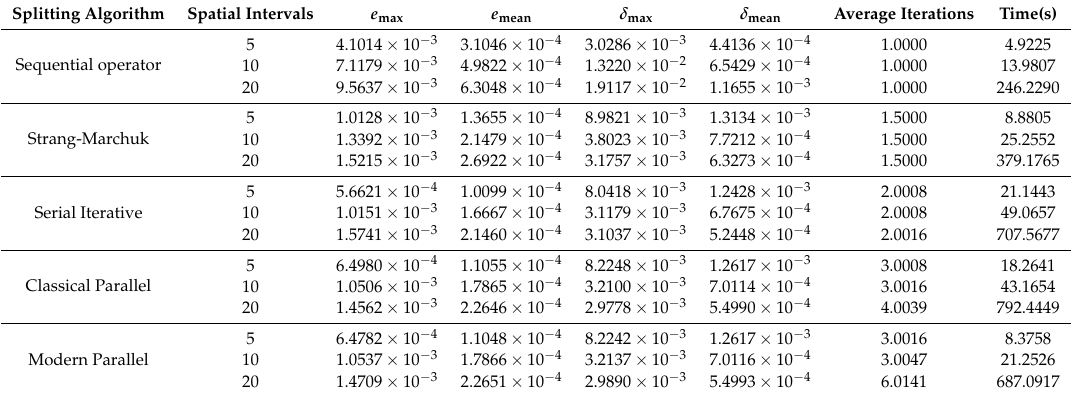
Table 14. Mixed convection-diffusion and Burgers’ equation. Results for the convection diffusion decomposition using the second order scheme for the spatial discretization with 10 temporal steps and different number of spatial subintervals.